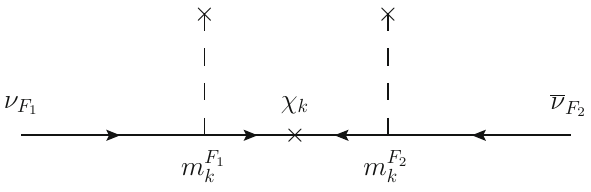
Fig. 2 Tree level diagram to generate the entries of a effective 3 × 3 mass